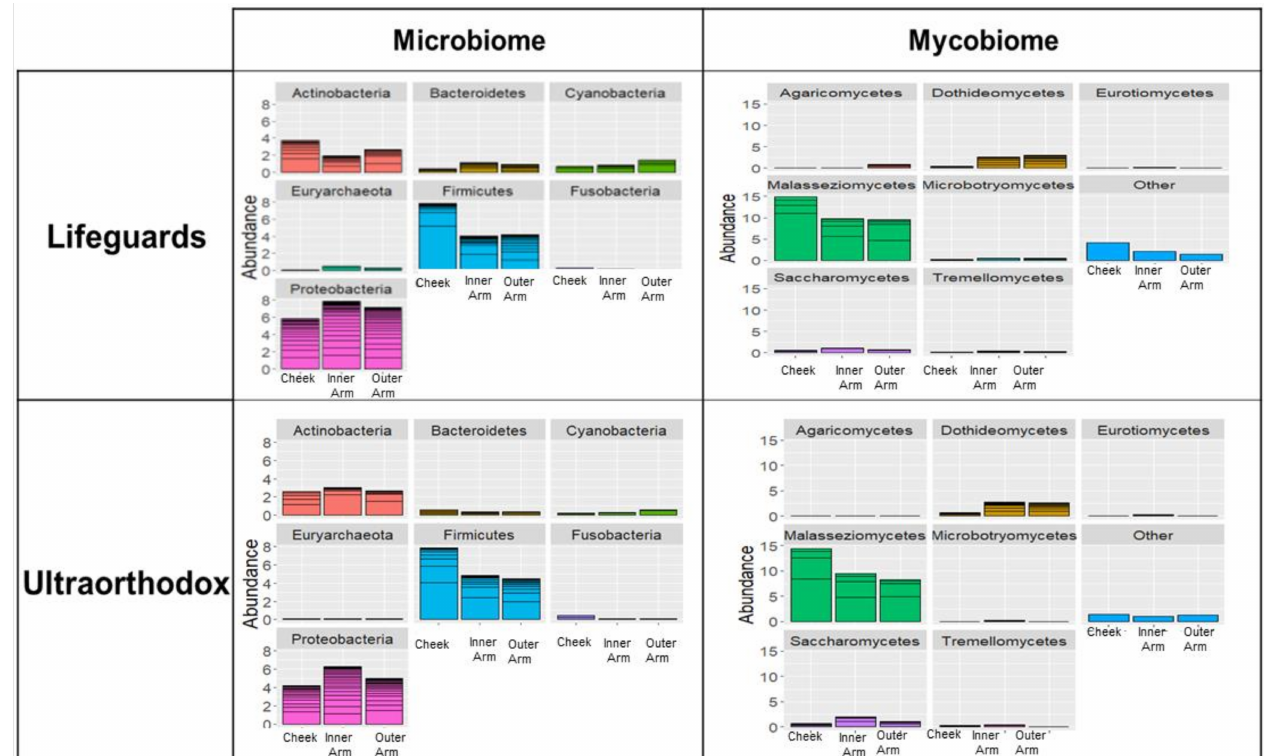
Figure 1. An analysis of OTU abundance by phylum. A comparison of the microbiomes and mycobiome of the two groups—mean relative abundance (>1%), at least 10% of reads in at least one sample. The bacterial and fungal microbiomes of each group, before and after summer, were compared, focusing on phyla with >1% relative abundance (Figure 2). No major seasonal effects were observed in any study groups based on the Wilcoxon signed ranks test.